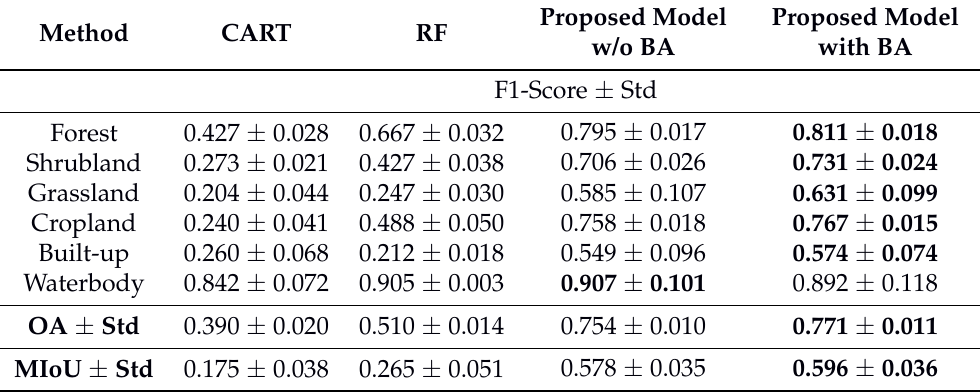
Table 2. The classification performance between pixel-based classification methods and our proposed model without and with the band attention (BA)